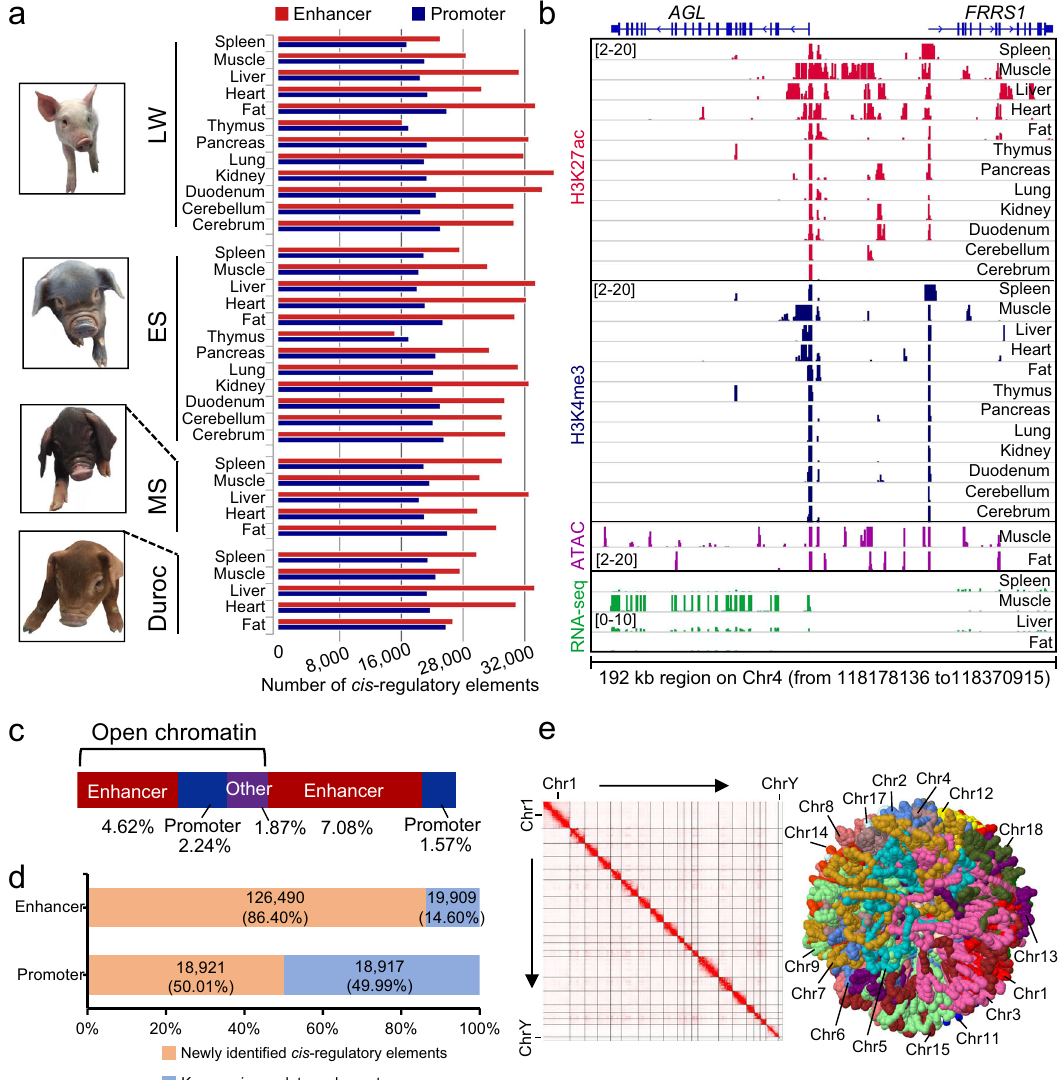
Fig. 1 Cis -regulatory element landscape of the pig genome. LW, ES, and MS represent Large White, Enshi Black, and Meishan breeds, respectively. a Summary of cis- regulatory elements (enhancers and promoters) identi fi ed in various tissues of four pig breeds. b Genome browser views of ChIP-seq, ATAC-seq, and RNA-seq data at the AGL and FRRS1 loci in tissues of LW pig. The numbers in the brackets located in the respective ChIP-seq, ATAC-seq, and RNA-seq tracks indicate their signal intensities. c A bar plot showing the percentage of cis- regulatory elements annotated in the pig genome. The percentage of enhancers (or promoters) in the black bracket were in genomic regions of open chromatin. “ Other ” indicates the proportion of open chromatin regions that did not overlap with enhancers or promoters. d Percentages of cis- regulatory elements newly identi fi ed in this study (salmon) and recovered by UCSC TSSs or published data (blue) from pig pluripotent stem cells 24 and liver tissue 25 . e Overview of Hi-C heatmap matrix (left) and a simulated structure of 3D chromatin (right) in pig skeletal muscle. A Lorentzian objective method 27 and GenomeFlow v2.0 28 were used for